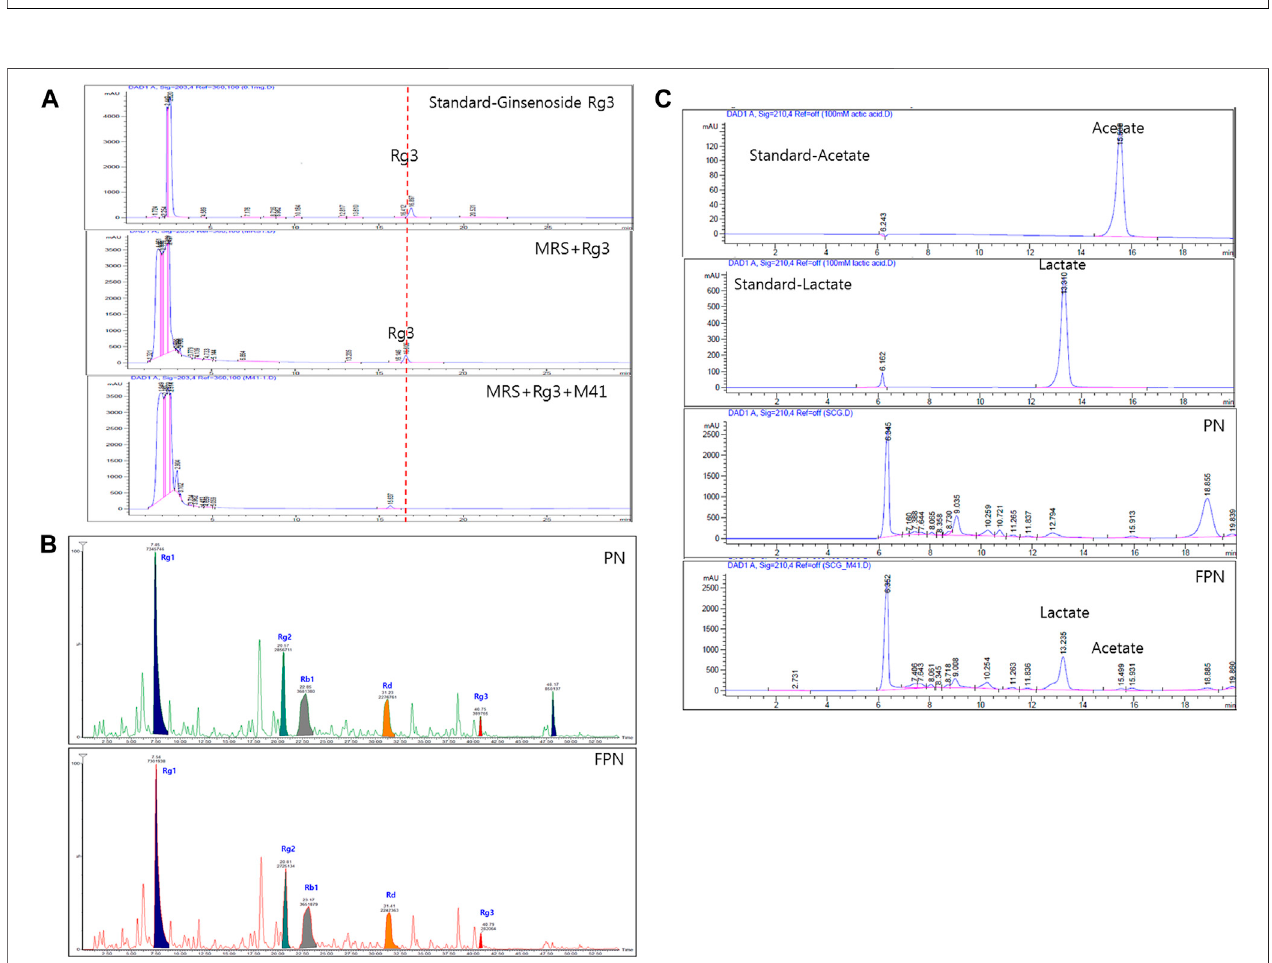
FIGURE 2 | Pro fi le analysis of active compounds before and after fermentation of PN. (A) Ginsenoside Rg3 was metabolized by M41 which was measured by HPLC. (B) UPLC-TOF-MS of ginsenosides and (C) HPLC with UV detector analysis of lactic and acetic acid.